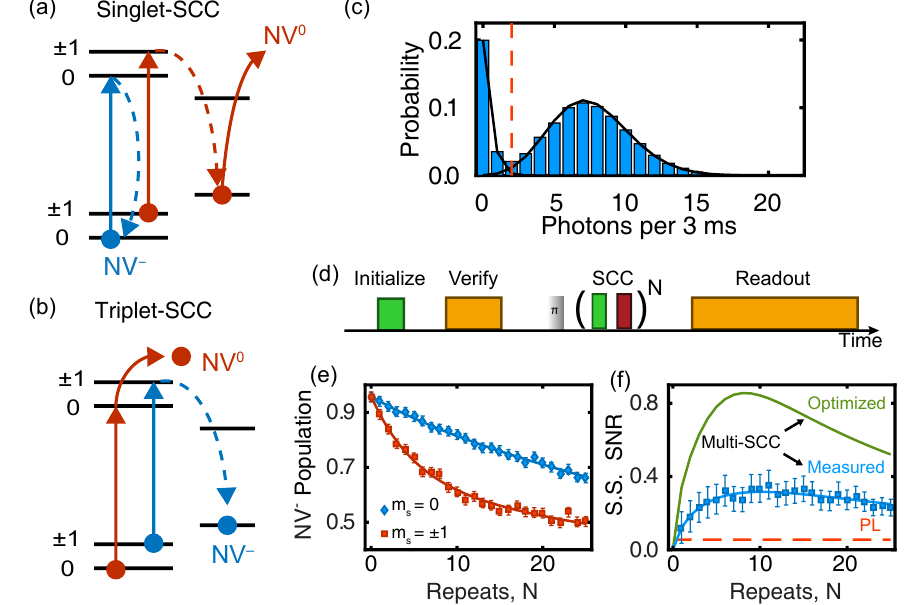
Figure 5. Spin-to-charge conversion (SCC). ( a , b ) Schematics of the spin-dependent ionization pathways for singlet spin-to-charge conversion (S-SCC) and triplet-SCC (T-SCC), respectively. Solid lines represent laser induced transitions, while dashed lines represent decay transitions. ( c ) Histogram of photon counts during a 3ms charge readout measurement with 592nm illumination [43]. ( d ) Timing diagram for the S-SCC protocol. ( e ) NV − population for different initial spin states as a function of the number of S-SCC repeats, N [43]. ( f ) Single-shot (S.S.) SNR for S-SCC as a function of N for the protocol as-demonstrated and for the optimal case assuming 100% singlet ionization probability. The corresponding traditional-PL SNR is the dashed line at SNR = 0.055 [43]. Panels ( c – f ) are from [43]. Copyright 2016 by the American Physical